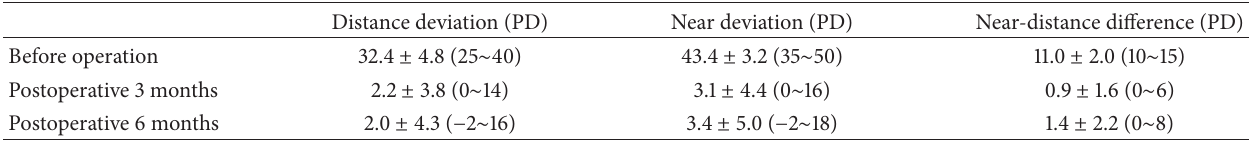
Table 2: Change in the mean postoperative angles. The mean distance deviation, mean near deviation, and near-distance difference (mean ± SD, range) showed significant postoperative reductions ( 𝑃 < 0.01